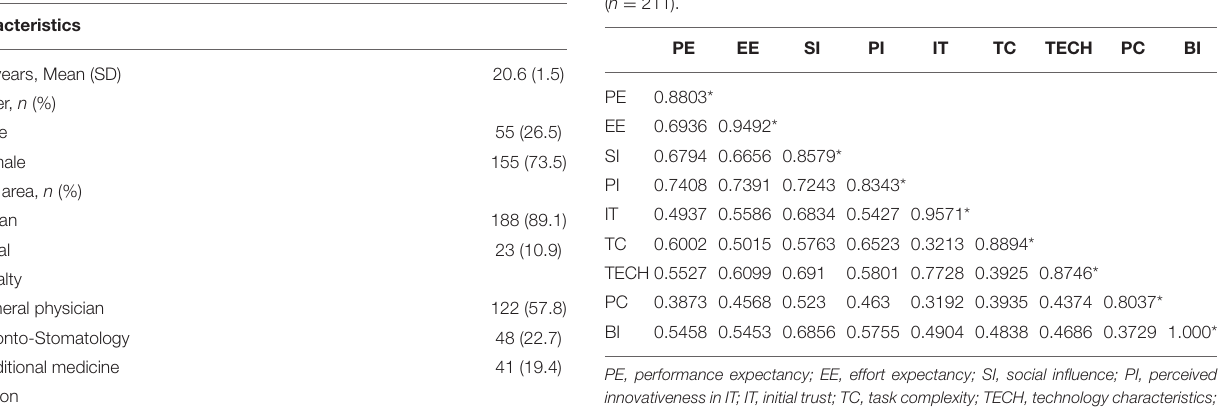
TABLE 1 | Characteristics of respondents ( n = 211).